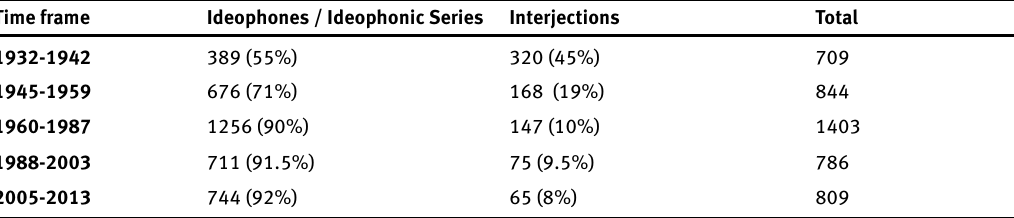
Table 9. Percentage of ideophones and interjections through the